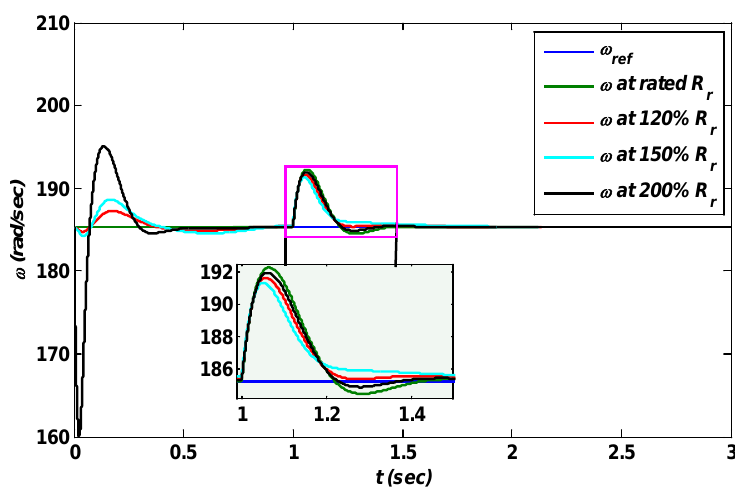
Figure 11. Speed control of indirect field oriented control IM using a PI controller.